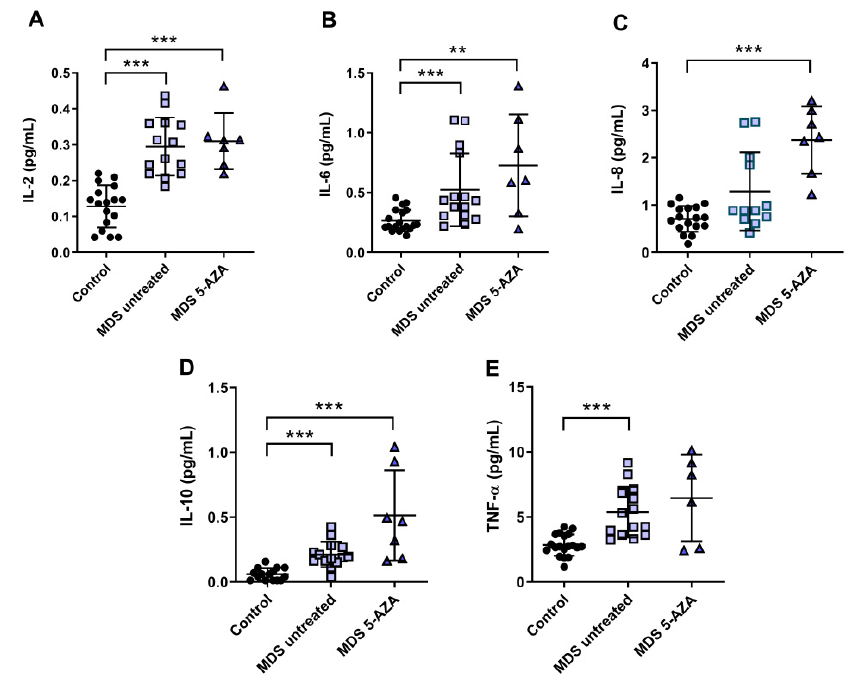
Figure 2. Concentration of pro- and anti-inflammatory cytokines in plasma samples from myelodysplastic syndrome (MDS) patients. ( A ) IL-2, ( B ) IL-6, ( C ) IL-8, ( D ) IL-10 and ( E ) TNF- α plasma concentration of MDS patients at diagnosis or with supportive care (untreated MDS) and MDS patients treated with 5-azacitidine (5-AZA MDS). Data are presented as mean ± SEM. ** p < 0.01, *** p < 0.001 vs. control.